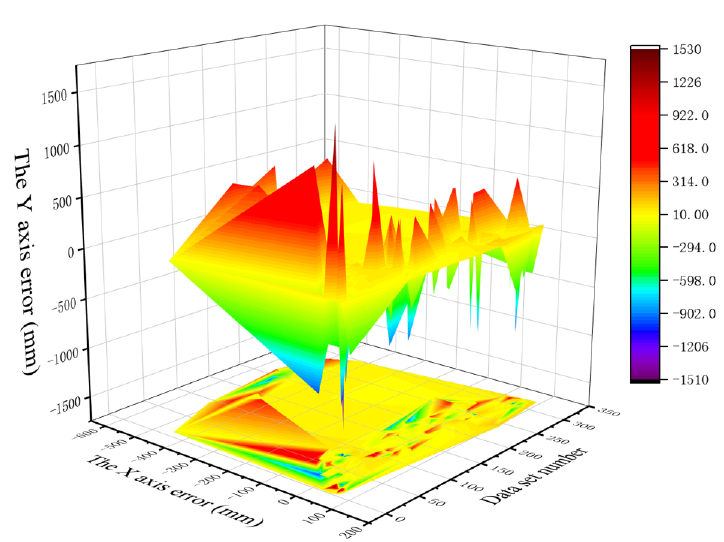
Figure 13. 2D ( X , Y ) accuracy of normal data sets based on traditional